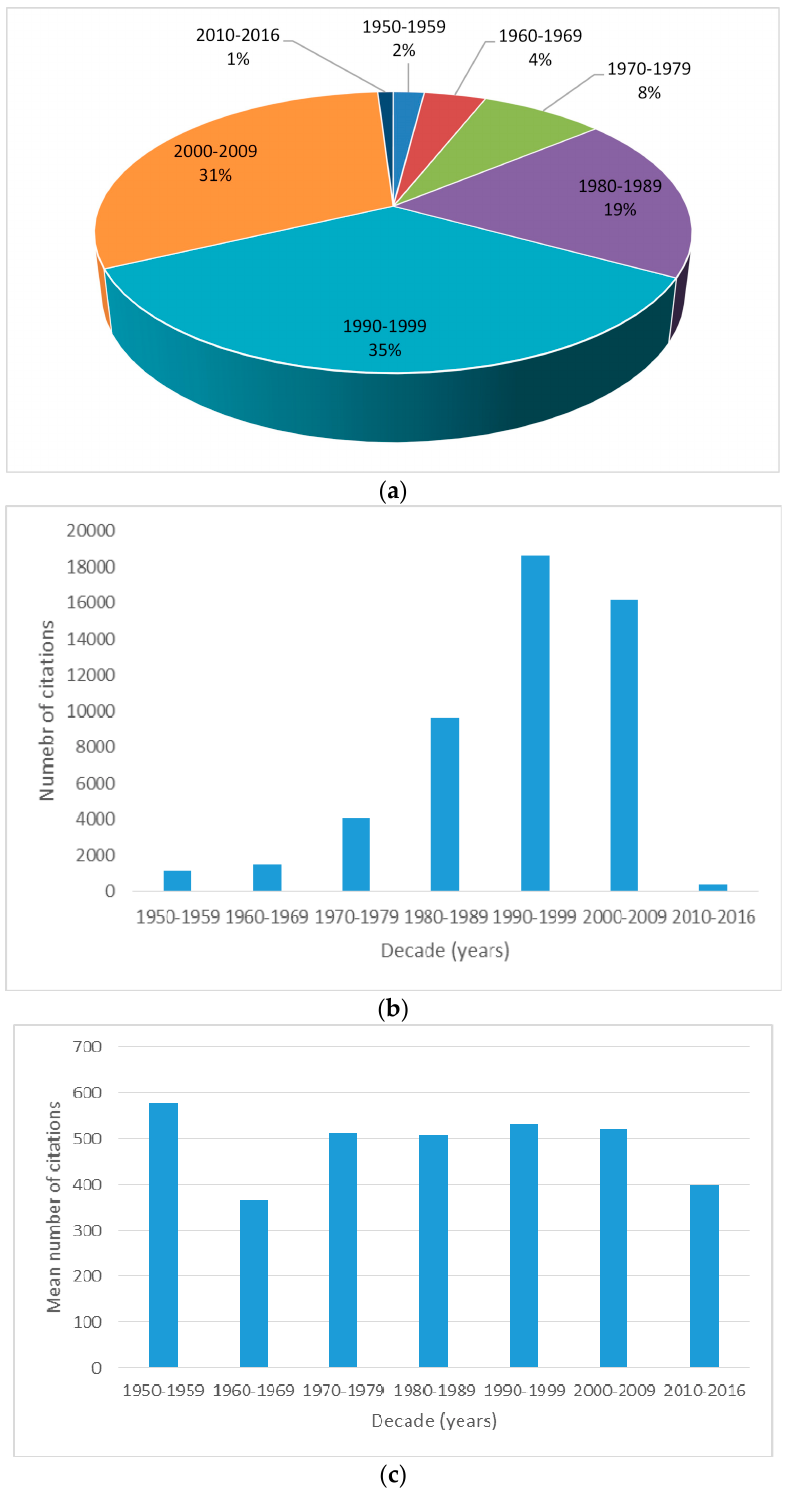
Figure 2. Years of publication ( a ) of the top 100 most cited articles in the field of melatonin research. Number of citations ( b ) and mean of the number of citations per decade ( c ).